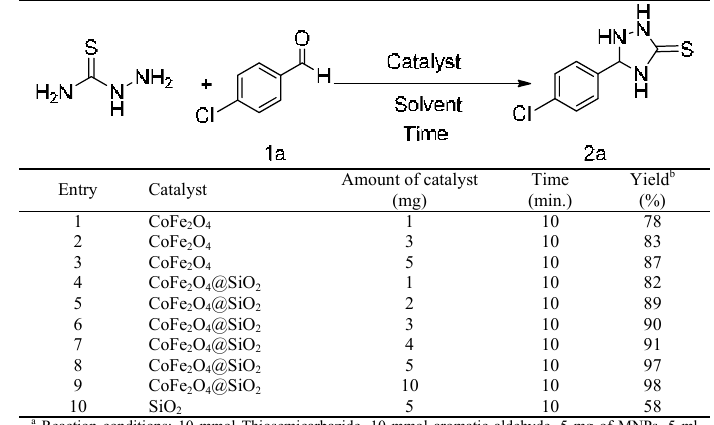
Table 3: Effect of MNPs loading towards the synthesis of 5-(4Chlorophenyl)-1,2,4-triazolidine-3-thione (a)